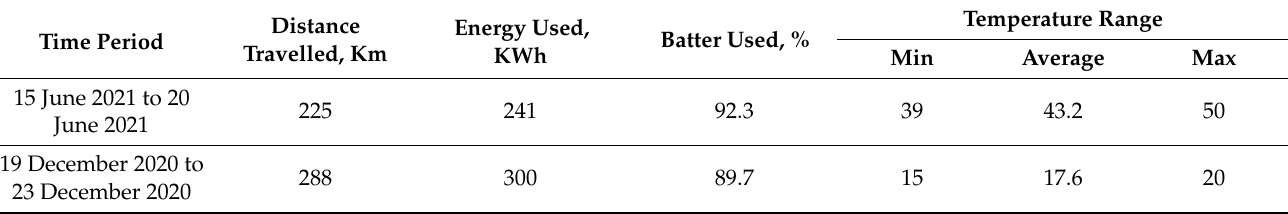
Figure 4. Effect of ambient temperature on the share of energy for battery conditioning. Table 3. The impact on ambient temperature on battery